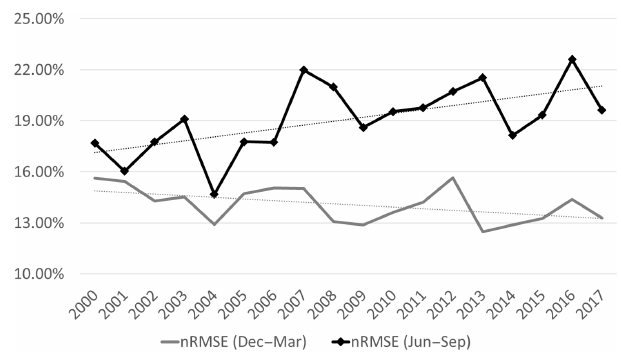
Figure 7. Changes of prediction accuracy (nRMSE) using CNN model in freezing (December–March) and melting (June– September) season (2000–2017; dotted lines show